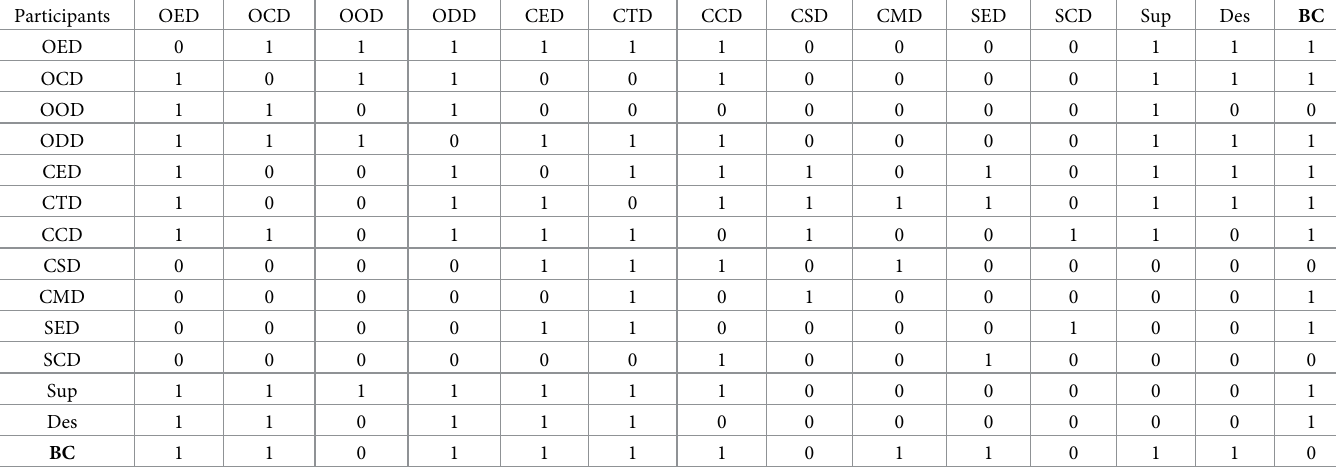
Table 2. 0–1 matrix of communication relationships after BIM